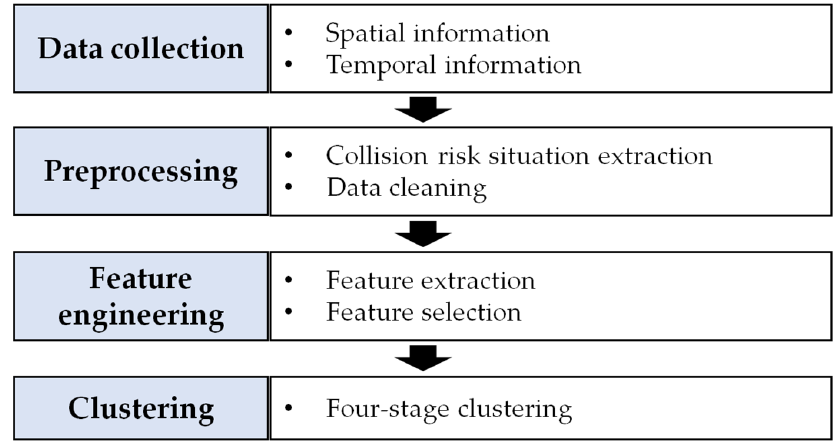
Figure 1. Workflow of the proposed methodology.